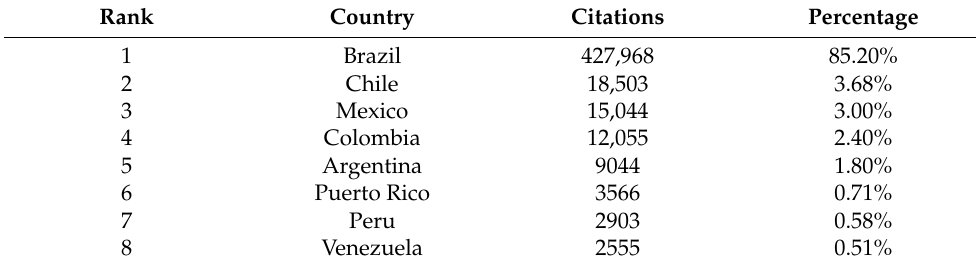
Table 2. Latin American countries with the highest number of citations (1996–2020). Rank